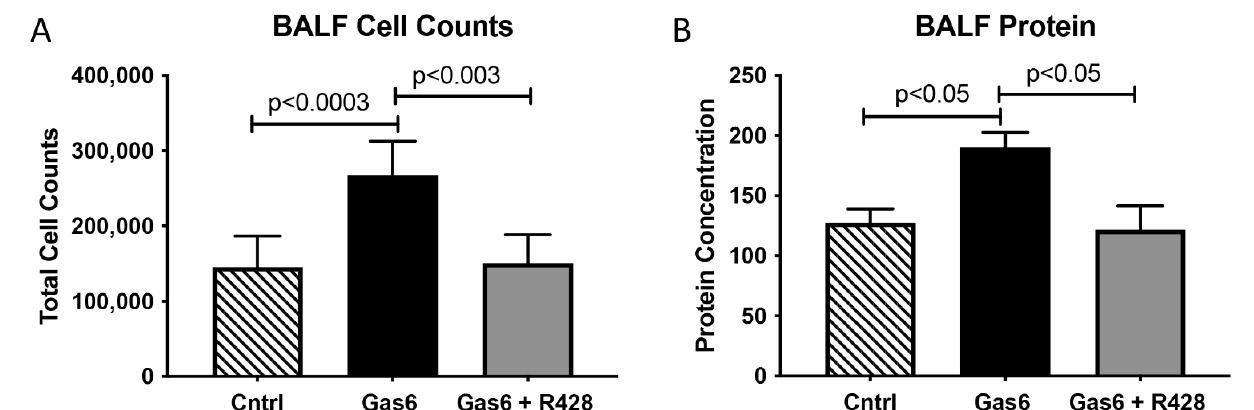
Figure 3. BALF analysis in control and treated animals. Cell count ( A ) and protein ( B ) were increased in the BALF of Gas6-treated animals as compared to controls. Levels were decreased in animals co-treated with R428 and Gas6 (n = 10). Representative data are shown with p ≤ 0.05.